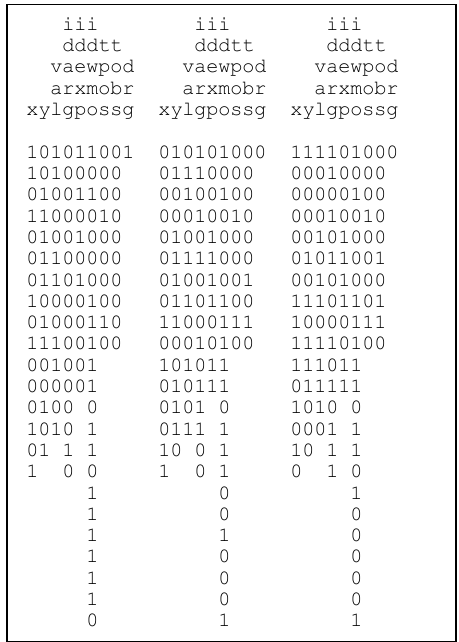
Table 4. Compressed data for 3 observations